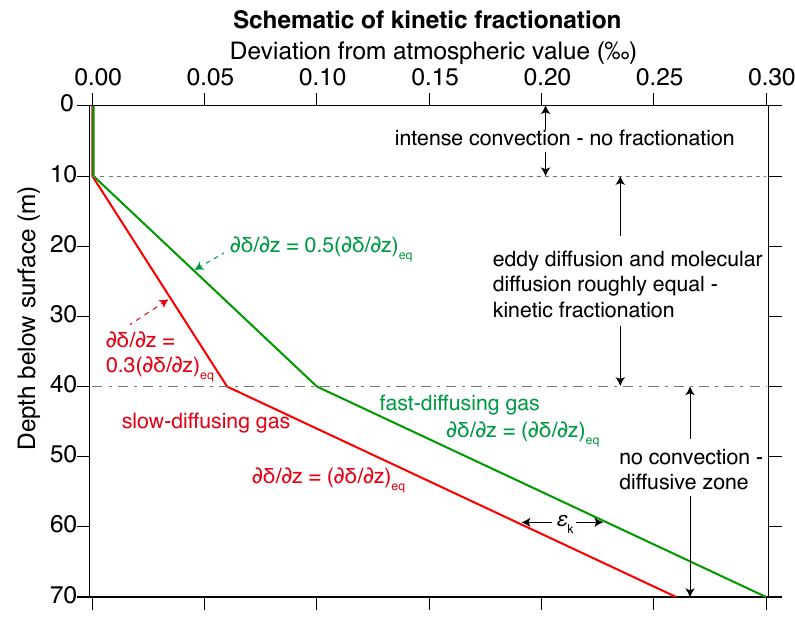
Fig. 1. Schematic illustrating the kinetic effect described here. Depth is plotted on the vertical axis, and the deviation of isotopic ratios ( δ) from the atmospheric ratio is plotted on the horizontal axis. For clarity, the effects are exaggerated and an idealized convective zone is shown in which mixing is constant between 10 and 40m and the Péclet number is 1 (for the fast-diffusing gas). Below 40m, there is no convection and the δ values exhibit the full gravitational equilibrium slope. Note that the amount of kinetic fractionation, ε k , does not increase in the diffusive